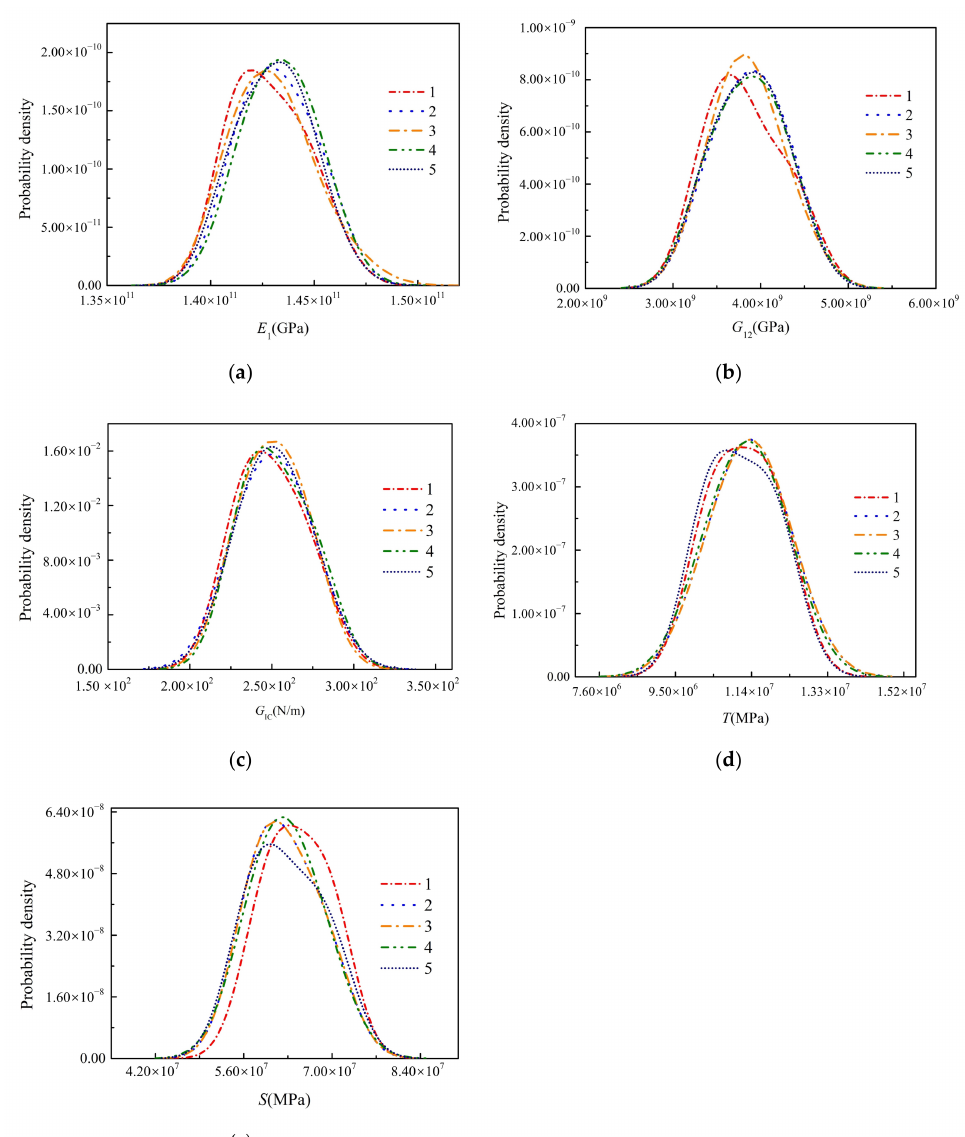
Figure 13. The posterior distribution of the properties obtained by five different